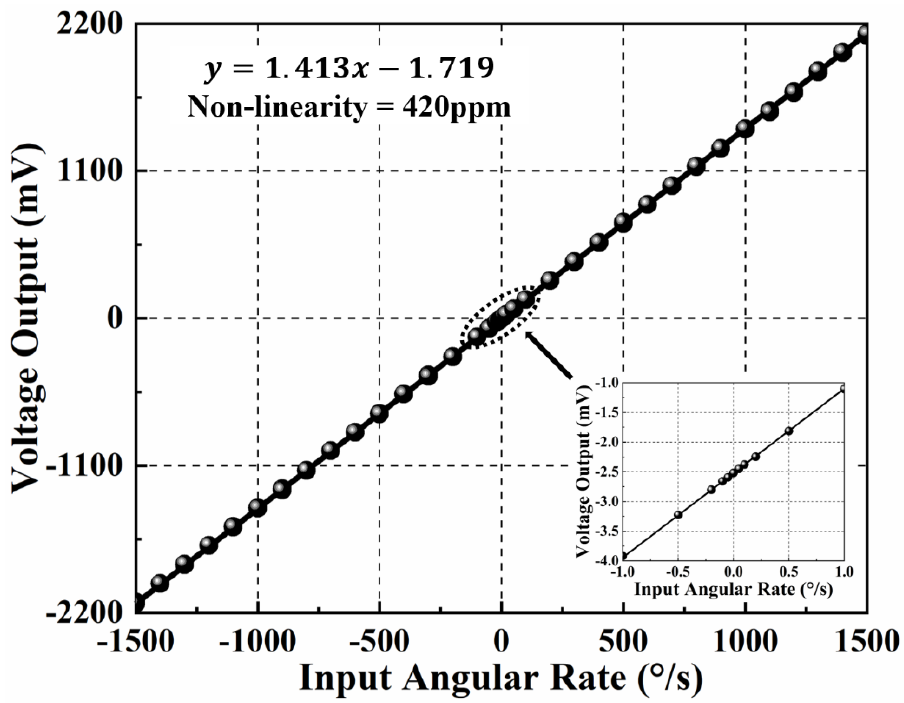
Figure 5. As-measured angular rate response and the non-linearity characteristics of MEMS TFGs.